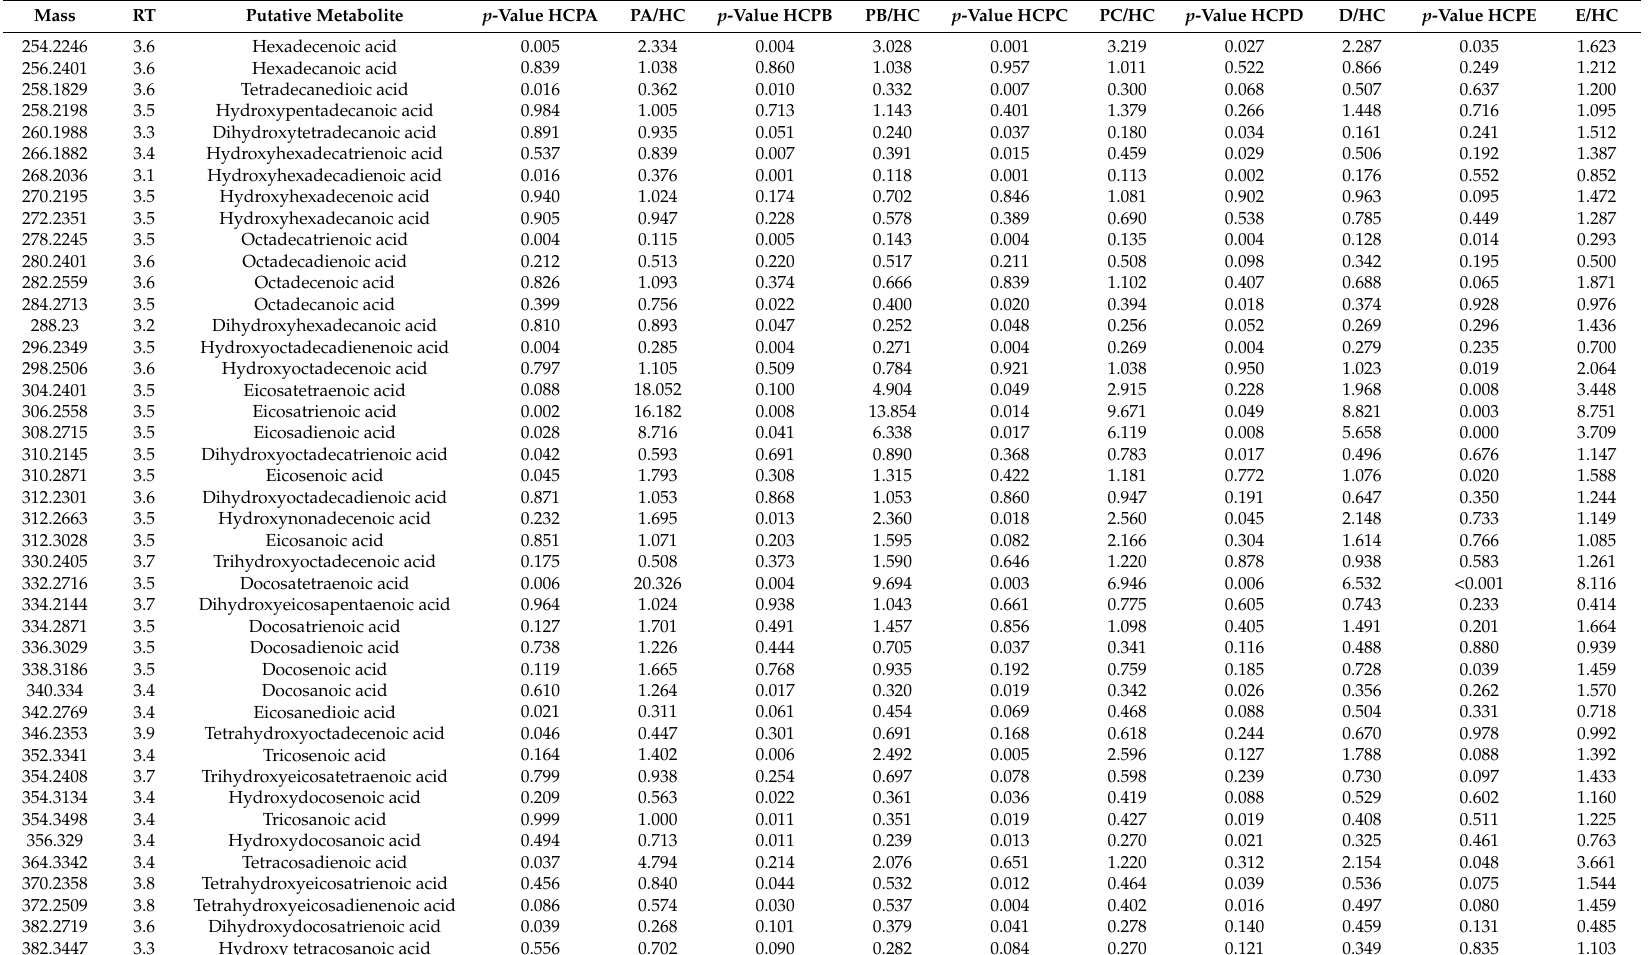
Table 2. The relative abundance of long chain fatty acids in the faecal extracts based on analysis of a ZICp HILIC